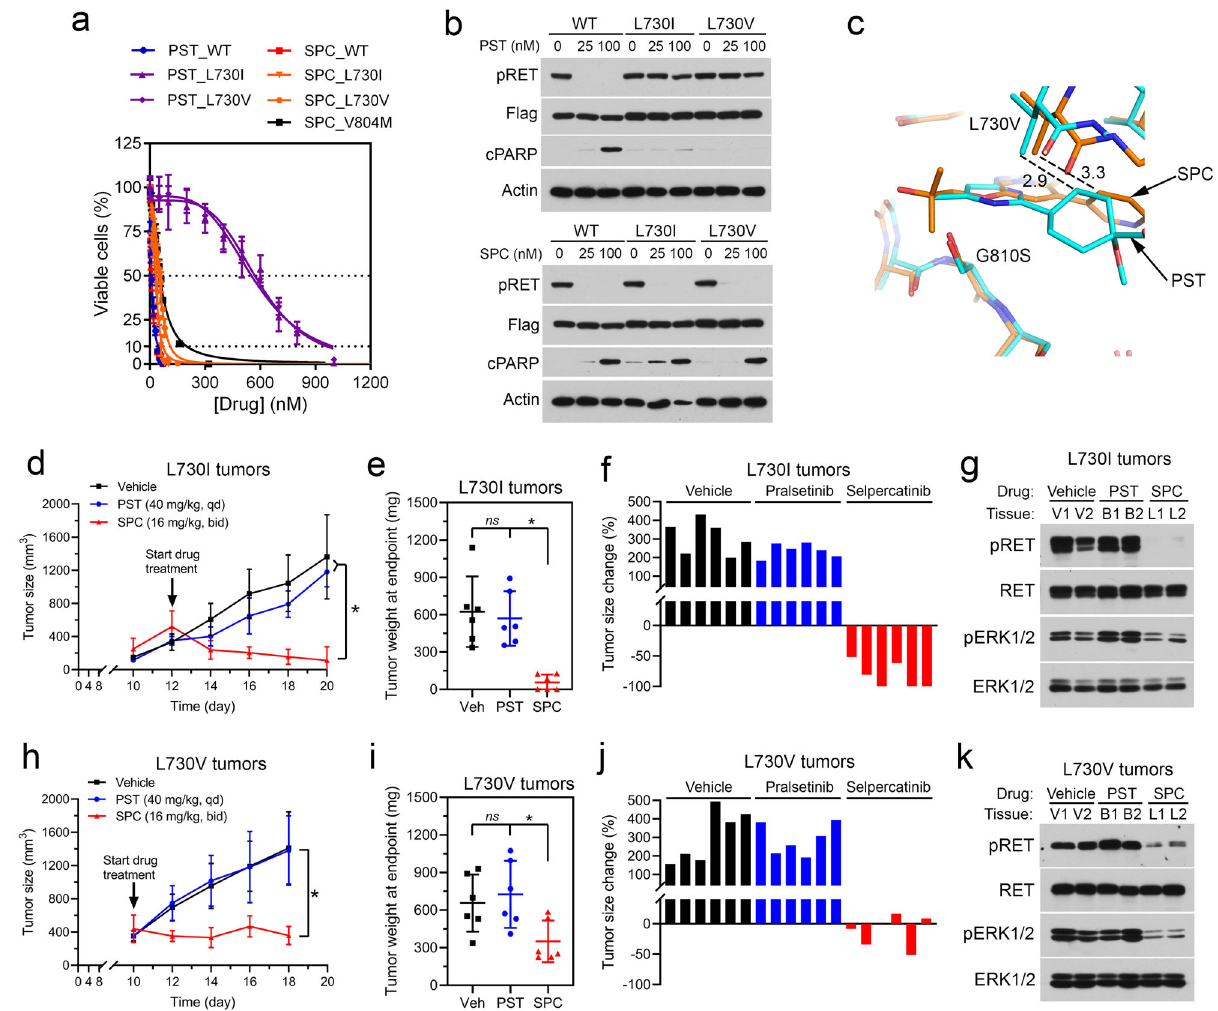
Fig. 1 L730V/I display different sensitivity to pralsetinib and selpercatinib. a BaF3 cells containing KIF5B-RET or KIF5B-RET with indicated mutations were treated with pralsetinib or selpercatinib for 3 days, and viable cells were determined. Data points are means and s.d. b Cell lysates were analyzed by immunoblotting with indicated antibodies. c The vicinity of L730 and G810 of RET kinase. The carbon atoms of the pralsetinib complex (PDB: 7JU5) are colored cyan, and those of the selpercatinib complex (PDB: 7JU6) are colored orange. The sidechain at site 730 has been changed to a valine, modeled in its most favorable state in the absence of the drugs. G810 has been changed to serine. d – g data from L730I tumors. d BaF3/KIF5B-RET(L730I) xenograft tumors were treated with pralsetinib, selpercatinib, or vehicle. Tumor sizes were measured on the indicated days. The data shown are the mean ± s.d. e Tumor weight at the endpoint. The error bars shown are mean ± s.d. * p < 0.05. ns, p > 0.05. f Waterfall plot of tumor size change at the endpoint from the baseline (prior to drug treatment). Each bar corresponds to a tumor in each mouse (6 per group). g Tissue samples from two different mice in each group were analyzed by immunoblotting with the indicated antibodies. PST pralsetinib, SPC selpercatinib. h – k data from the BaF3/KIF5B-RET(L730V) tumors. The experiment was performed in parallel to the BaF3/KIF5B-RET(L730I) tumors as described above for the ( d – g )